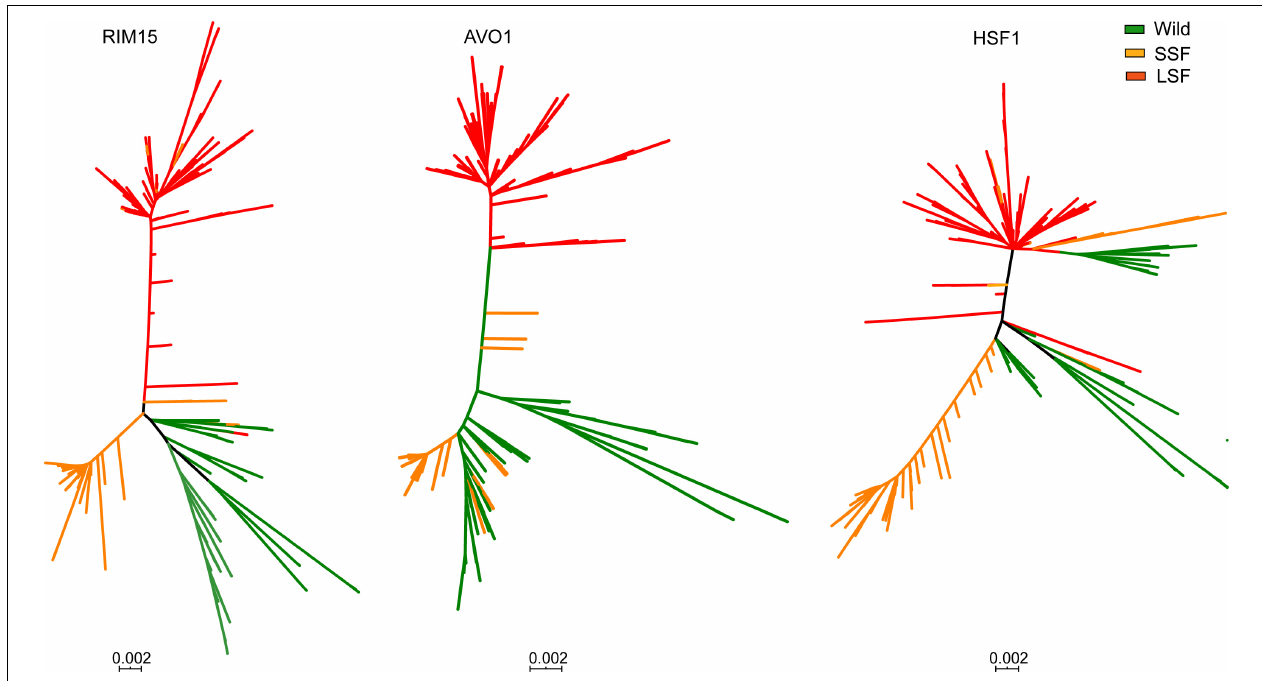
FIGURE 6 | Unrooted phylogenetic trees of 612 worldwide isolates of S. cerevisiae constructed from the sequences of genes AVO1 , HSF1, and RIM15 , respectively. Isolate branches are colored according to the positions of the isolates clustered in the wild, liquid-state (LSF) and solid-state fermentation (SSF) groups in the tree constructed from the whole genome SNPs as shown in Supplementary Figure 1